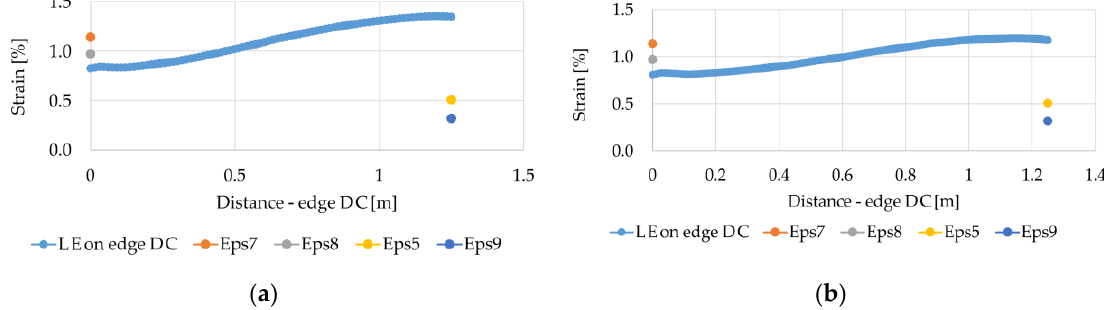
Figure 10. Comparison of the FEM calculation results with the results of strain measurements: ( a ) variant A1; ( b ) variant A2.